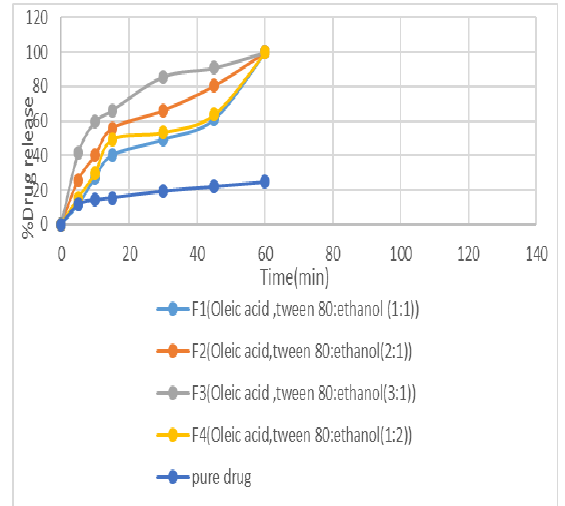
Figure 7. A comparative dissolution profile of felodipine nanoemulsions (F5, F6,F7,F8 and pure felodipine) in 500ml of 0.1 N HCl (containing 1% tween 80) dissolution medium at 37 °C.